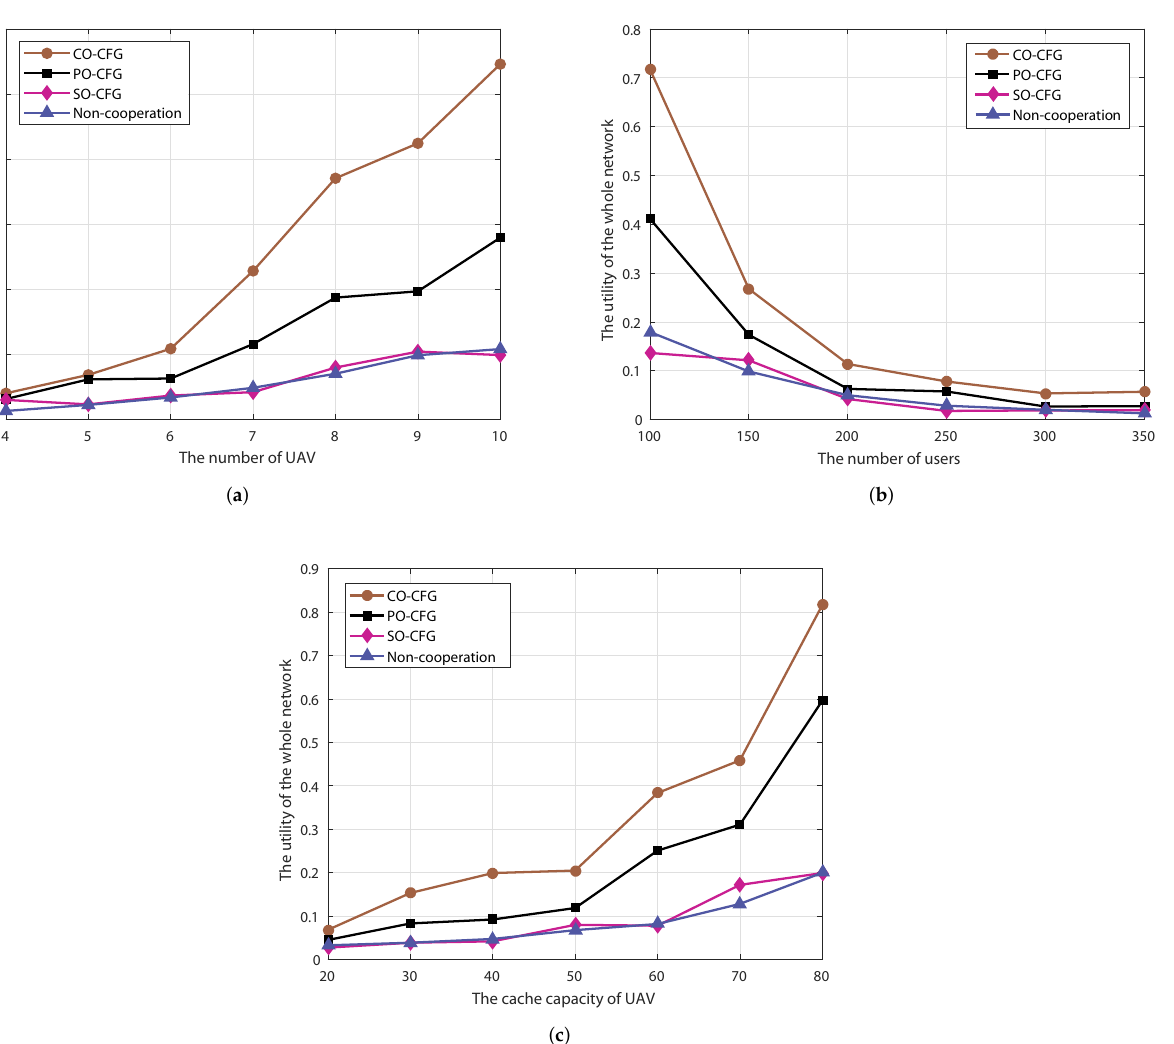
Figure 5. The utility of the whole network with ( a ) differing numbers of UAVs, ( b ) differing numbers of users and ( c ) varying UAV cache